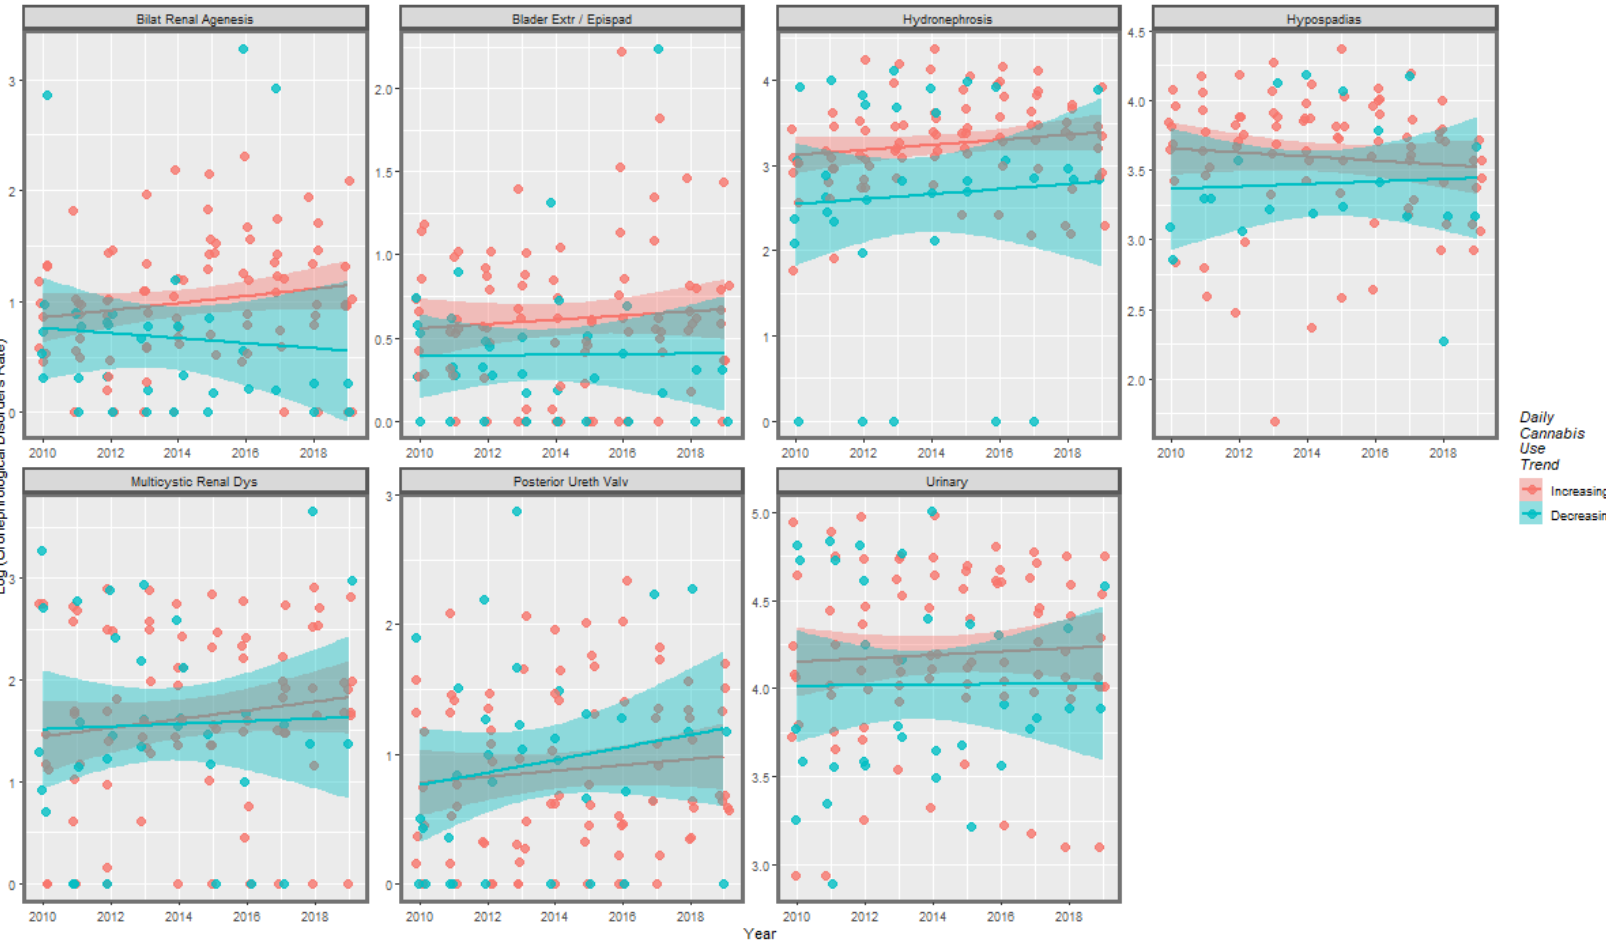
Figure 13. Rate of log (uronephrological congenital anomaly rate) against time by rising of falling daily cannabis use rates by congenital anomaly.